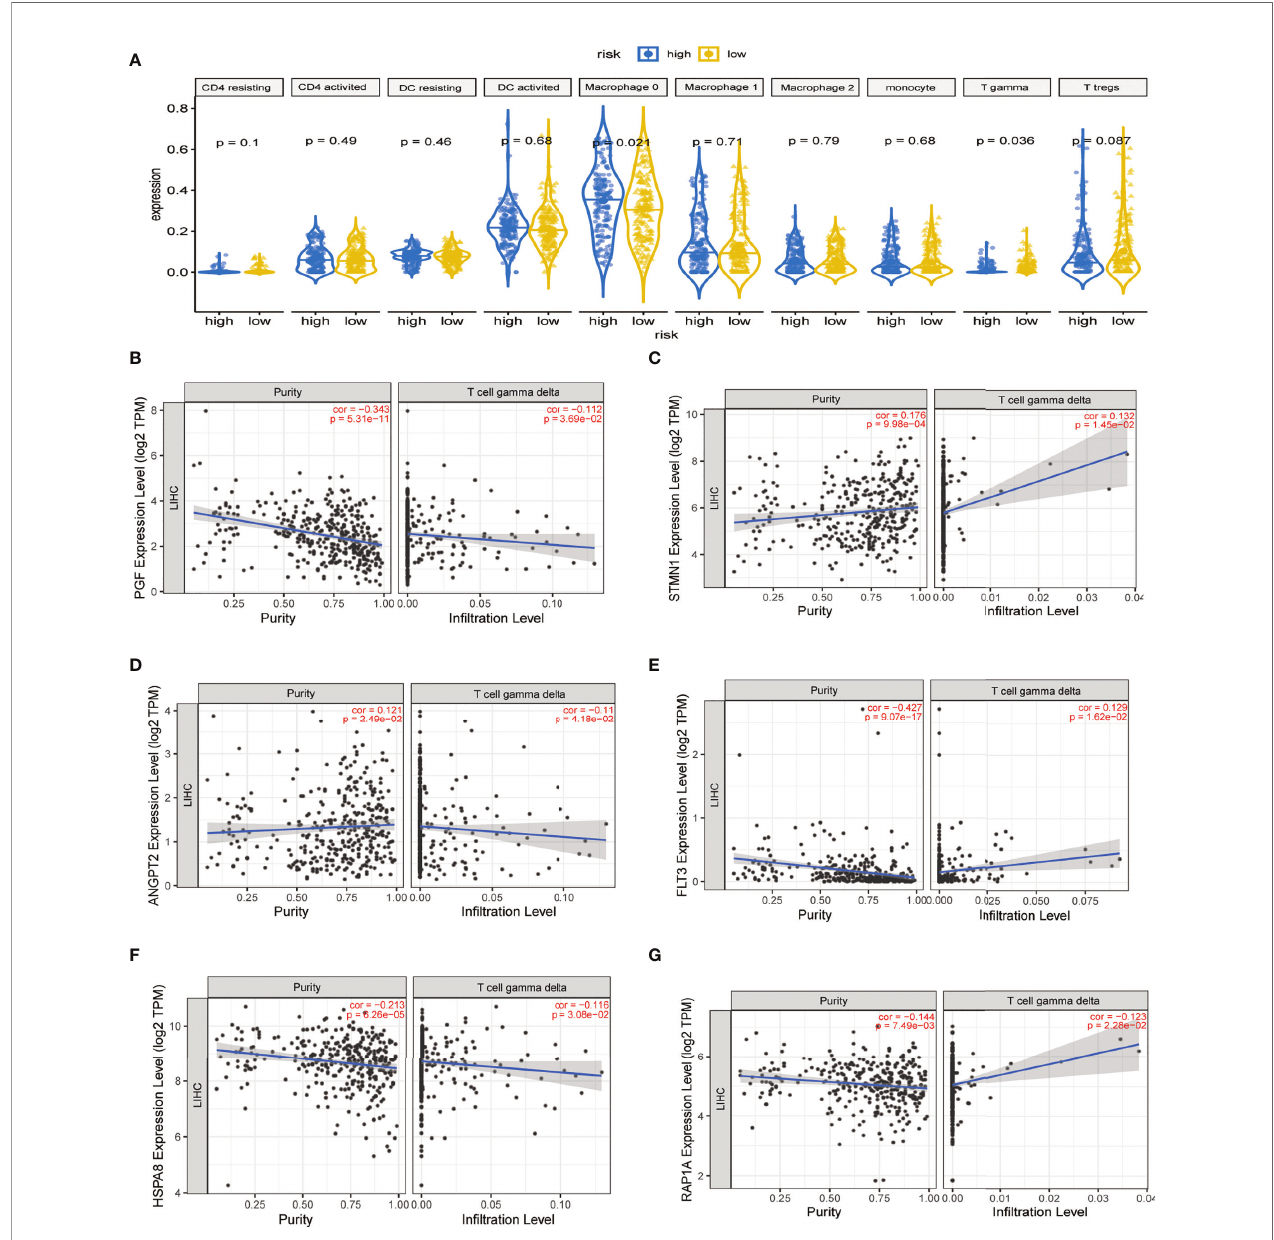
FIGURE 7 | Immune in fi ltration construction and validation in HCC. (A) Plot for comparison of the immune cell fraction difference between high risk and low risk. Fractions of each immune cell type were compared. Association of hub genes ’ expression with immune in fi ltration in HCC. (B) PGF (C) STMN1, (D) ANGPT2, (E) FLT3, (F) HSPA8, and (G) RAP1A. P < 0.05 denotes signi fi cance. Each dot represents a sample in the TCGA-LIHC